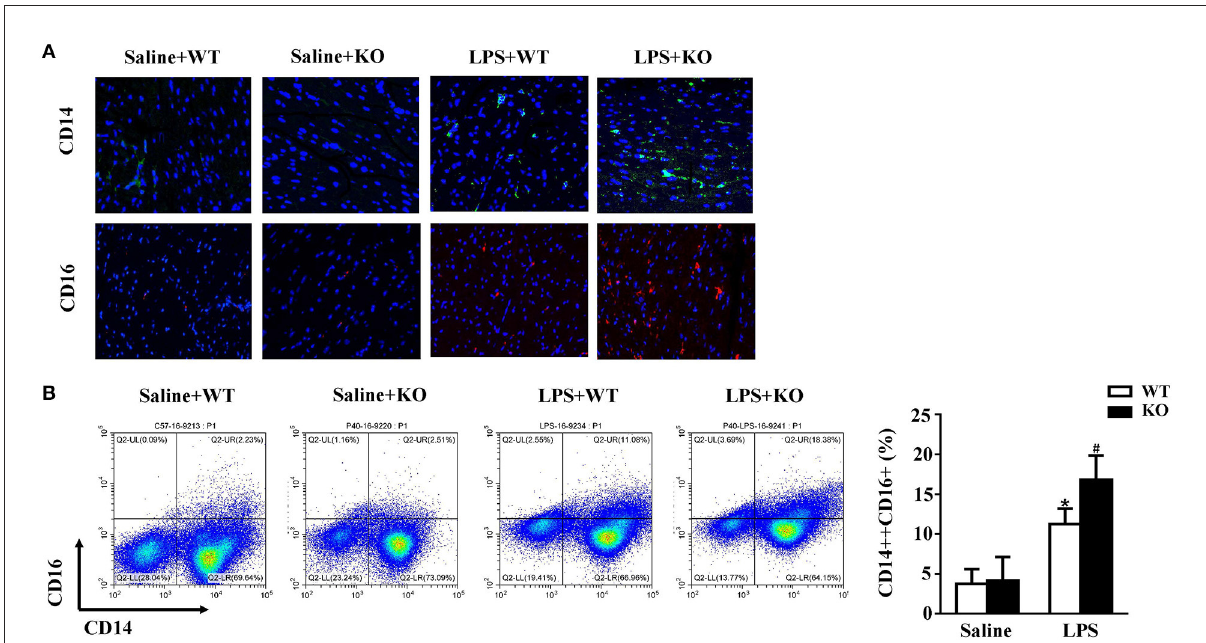
FIGURE4 IL-12p40 deletion increases monocytes infiltration. (A) The immunofluorescence analysis of CD14 and CD16 in heart sections of each group ( n = 6; scale bar, 50 µ m). (B) Flow cytometry analysis of CD14 ++ CD16 + monocyte percents in spleen tissues of mice in each group ( n = 6). * P < 0.05 compared with the Saline group. # P < 0.05 compared with the LPS + WT